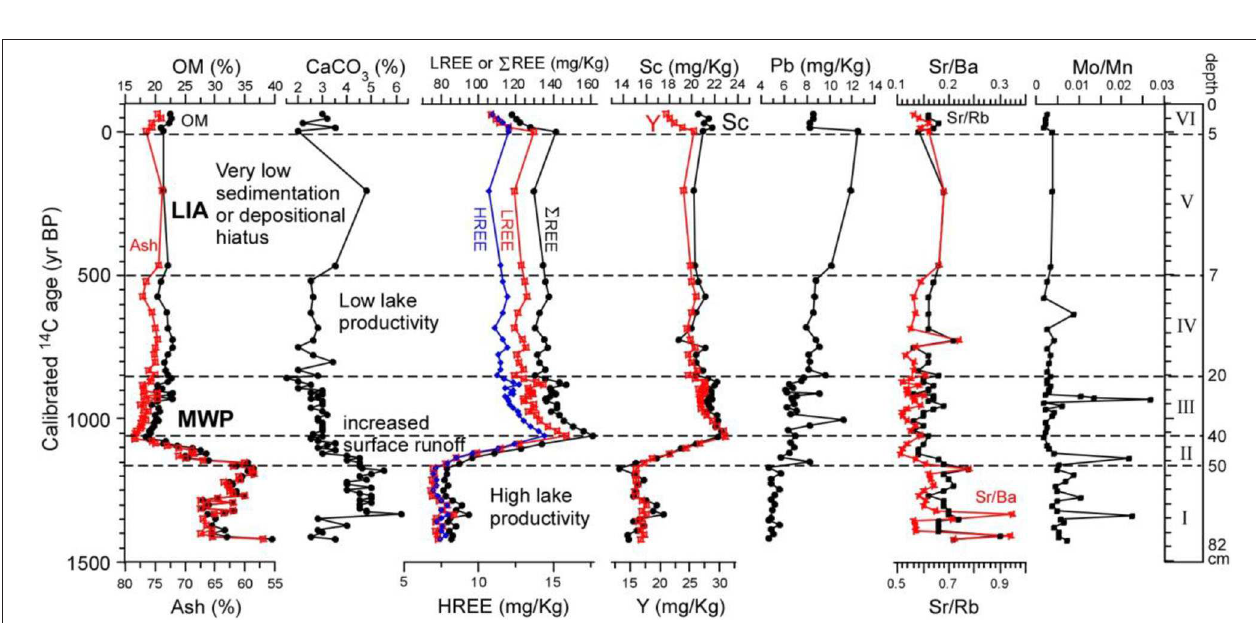
FIGURE 7 | Selected elemental concentrations in the lake sediments throughout the Manzherok Lake sediment core. Note that the units for Al, Ti, and Fe are in mg/g, whereas the rest of the elements are in mg/kg.